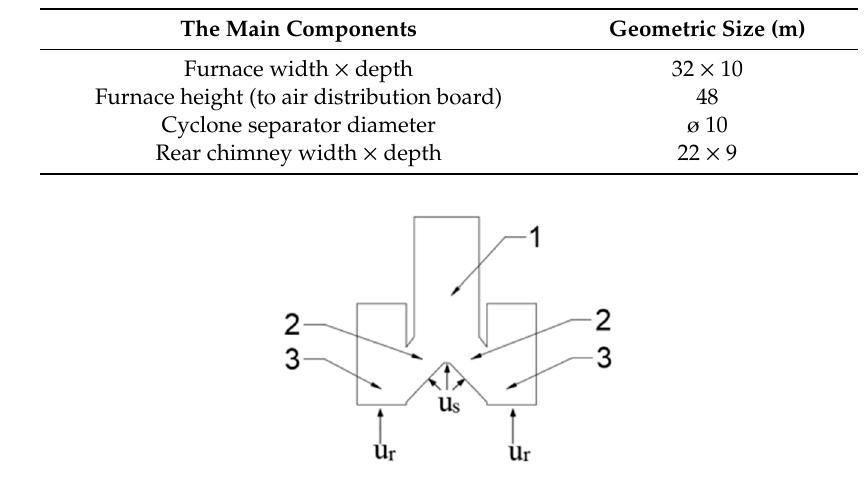
Figure 1. Return valve of the supercritical the Circulating Fluidized Bed (CFB) boiler.